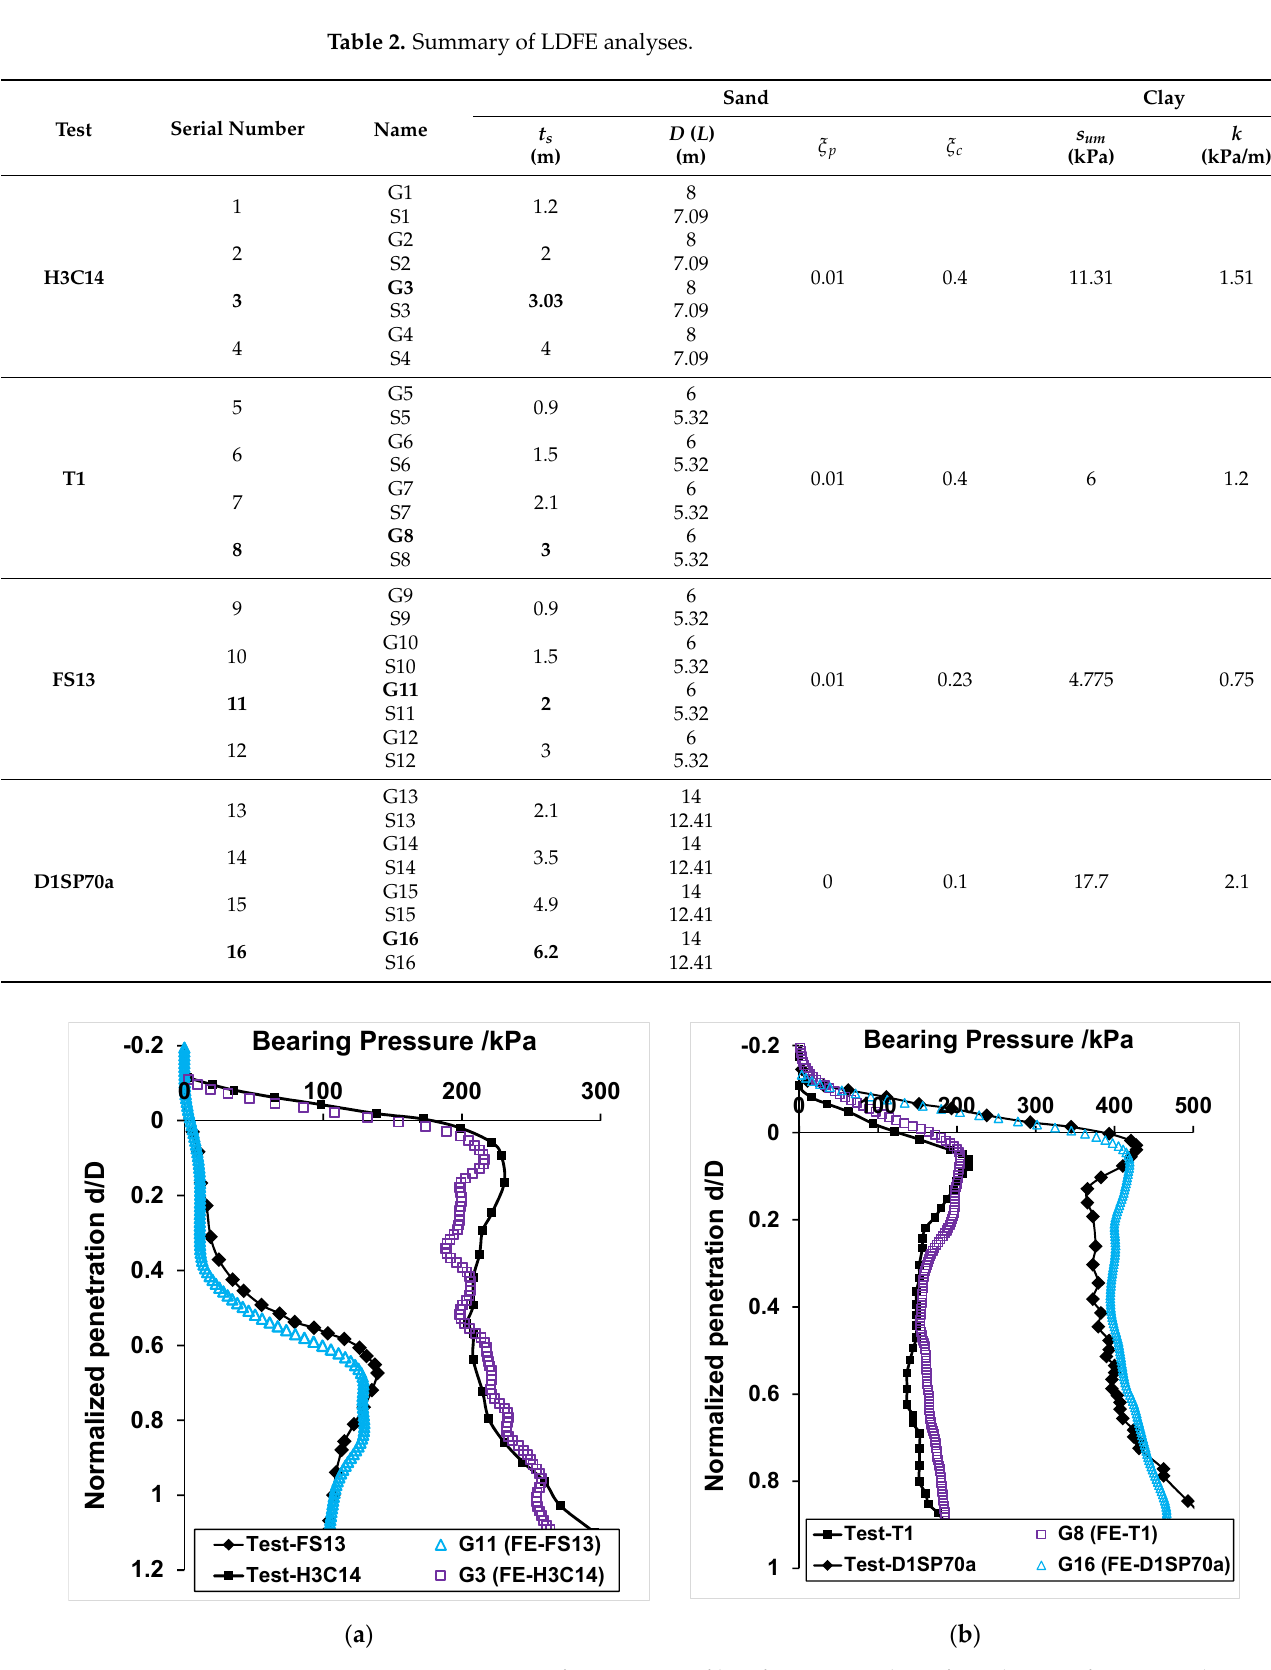
Figure 4. Comparison of resistance profiles of generic spudcans from the centrifuge test and numerical analysis: ( a ) test H3C14 and FS13; ( b ) test T1 and D1SP70a.